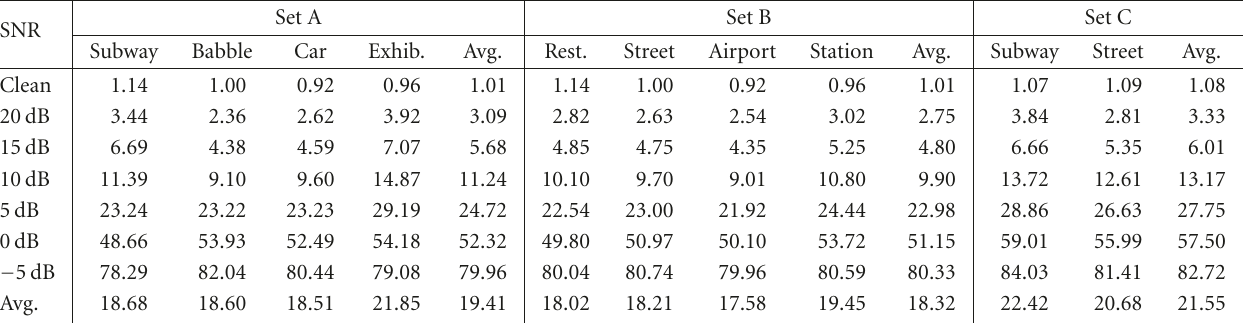
Table 4: Recognition results of the HEQ compensation technique on the Aurora 2 task under clean-condition training (WER %).